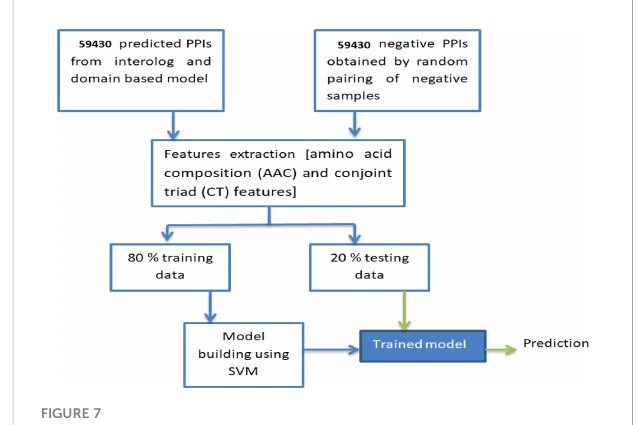
FIGURE 7 A schematic illustration of the machine learning